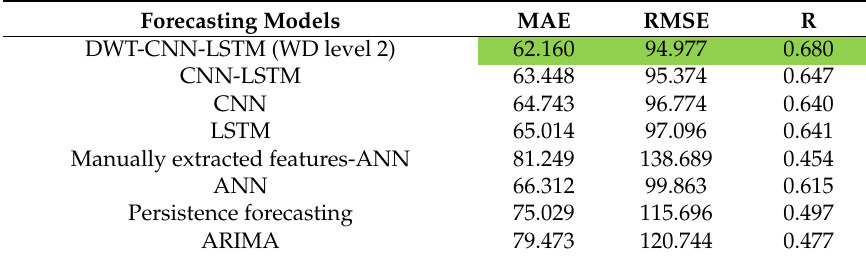
Table 15. The performance comparison of different heavy rainy days’ forecasting models using the dataset of Desert Rock